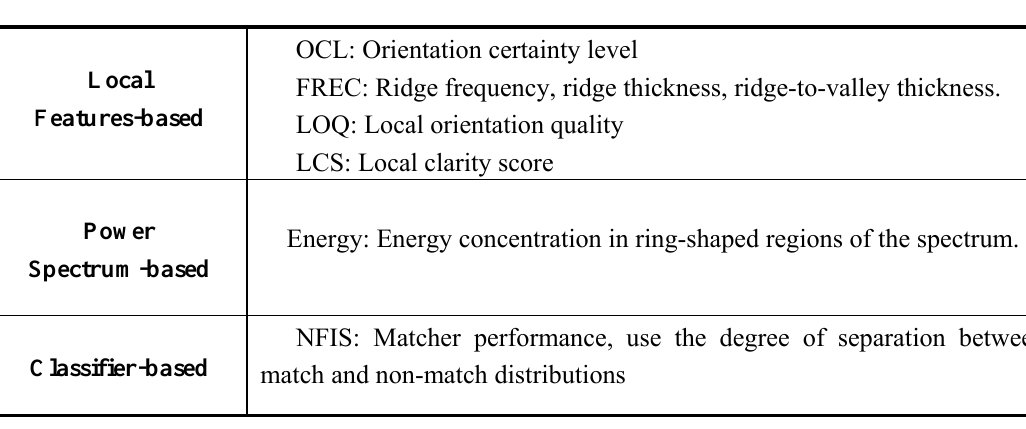
Table 1. Summary of Representative Quality